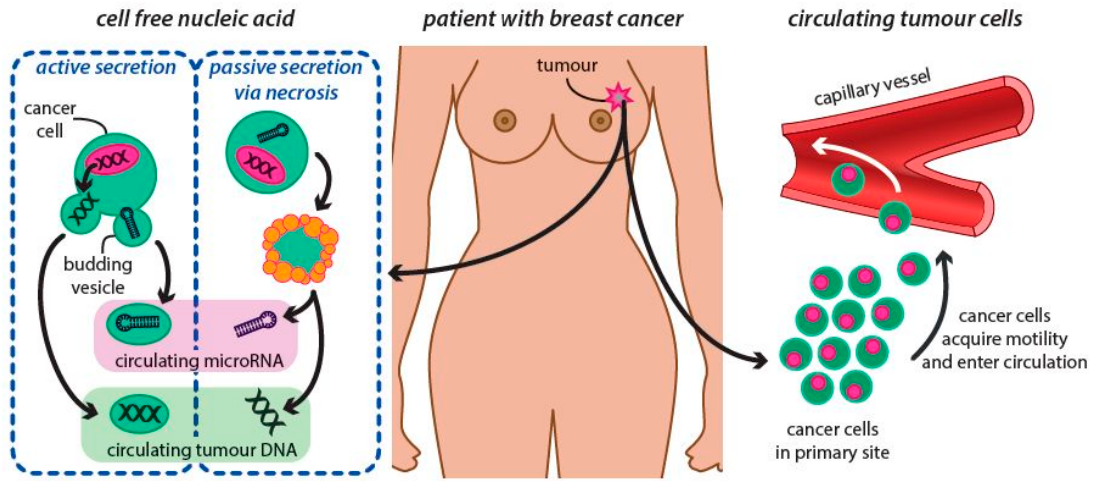
Figure 4. The background of the natural behavior of the malign BC disease leading to its spread through the circulating tumor cells and consequent secretion of cell free nucleic acids.